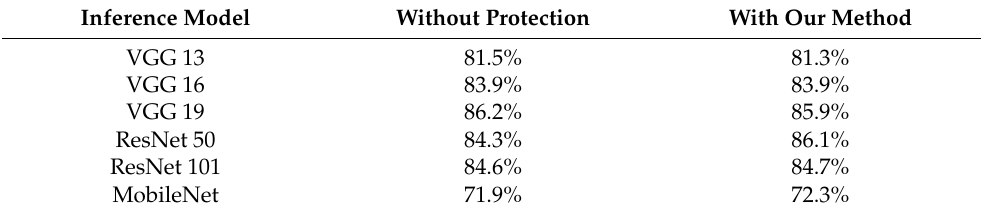
Table 4. Accuracy quantization on our method.